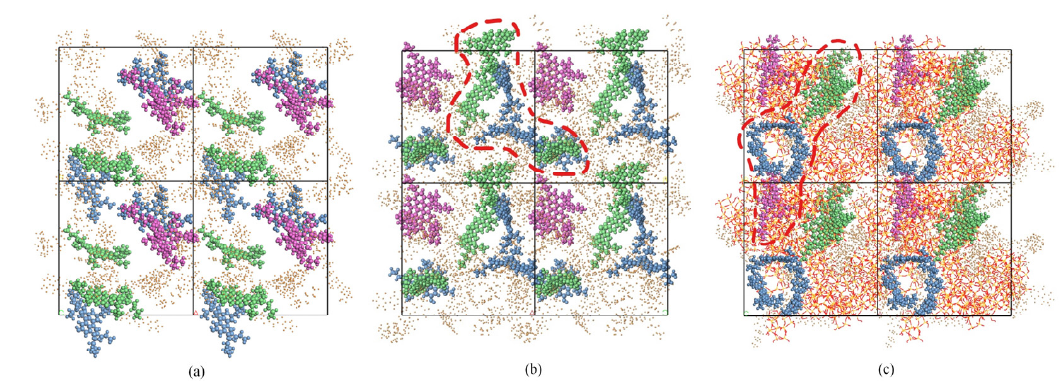
Figure 11. Illustration of the self-aggregation of asphaltenes in asphalt: ( a ) virgin asphalt; ( b ) aged asphalt; ( c ) RAM ( 2 × 2 repetitive units, blue refers to phenol molecules; green refers to thiophene molecules; purple refers to pyrrole molecules; yellow refers to resin molecules).